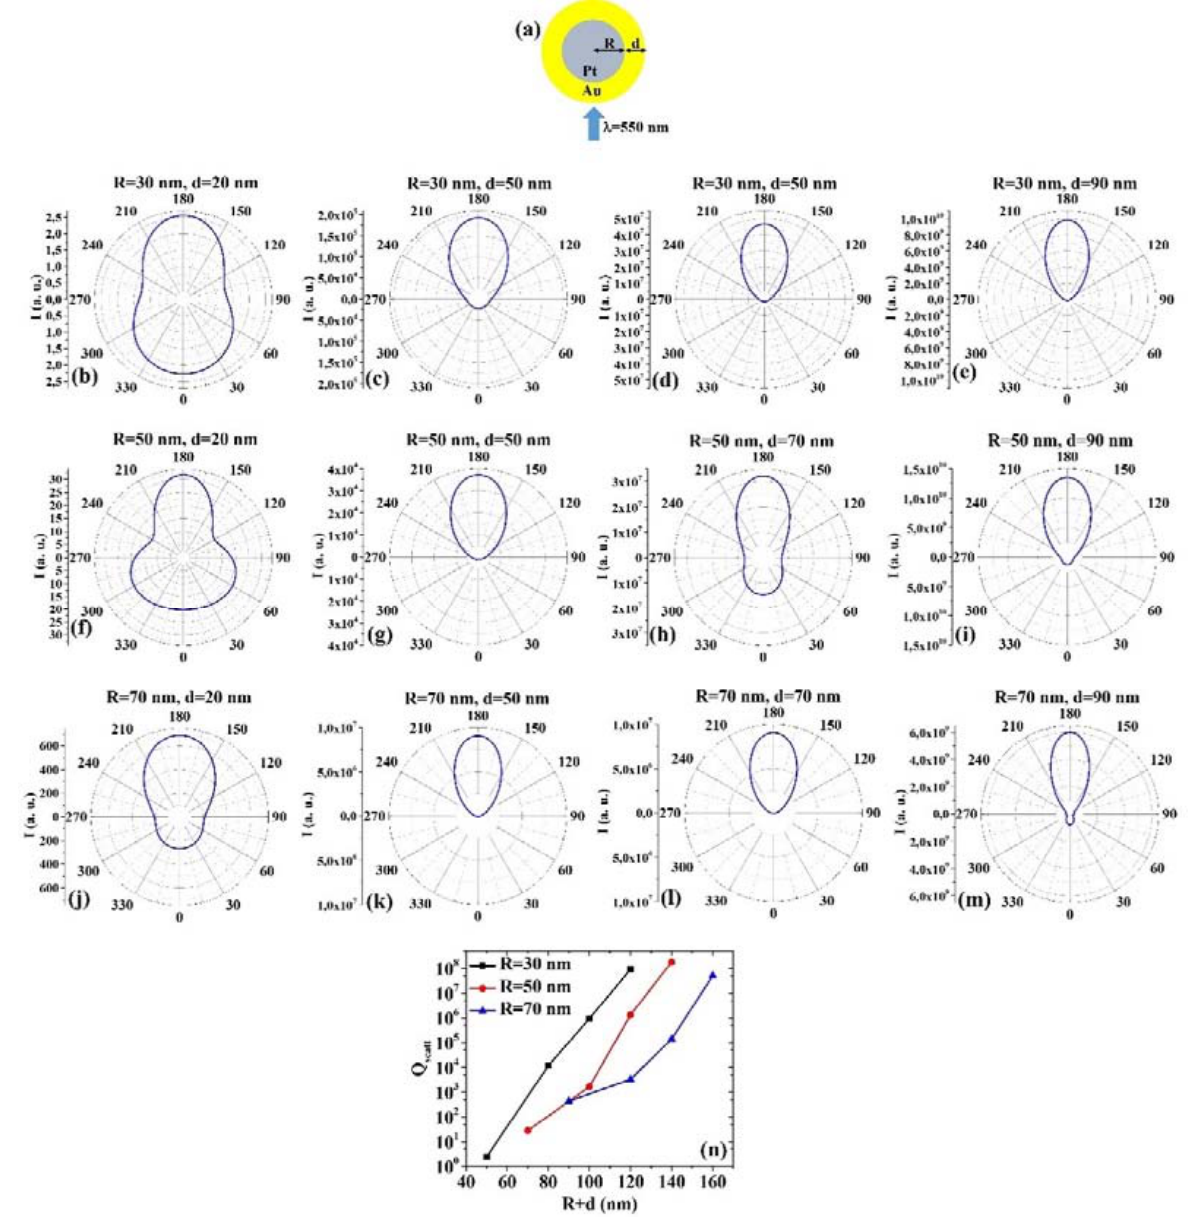
Figure 8. ( a ) Scheme of the structure of the simulated Pt/Au core/shell spherical particle with core radius R and shell width d and electromagnetic radiation of wavelength λ = 550 nm impinging on the particle from 0 ◦ . ( b – m ) Calculated polar diagrams for the intensity of the scattered light from the Pt/Au core/shell spherical particle changing the Pt core radius R and the Au shell width: ( b – e ) R = 30 nm and d = 20 nm ( b ), d = 50 nm ( c ), d = 70 nm ( d ), d = 90 nm ( e ); ( f – i ) R = 50 nm and d = 20 nm ( f ), d = 50 nm ( g ), d = 70 nm ( h ), d = 90 nm ( i ); ( j – m ) R = 70 nm and d = 20 nm ( j ), d = 50 nm ( k ), d = 70 nm ( l ), d = 90 nm ( m ). ( n ) Calculated scattering efficiency for the light (wavelength λ = 550 nm) scattering process of the Pt/Au spherical particle fixing the Pt core diameter (R = 30 nm black dots, R = 50 nm red dots, R = 70 nm blue dots) and increasing the Au shell width d from 20 nm to 90 nm.